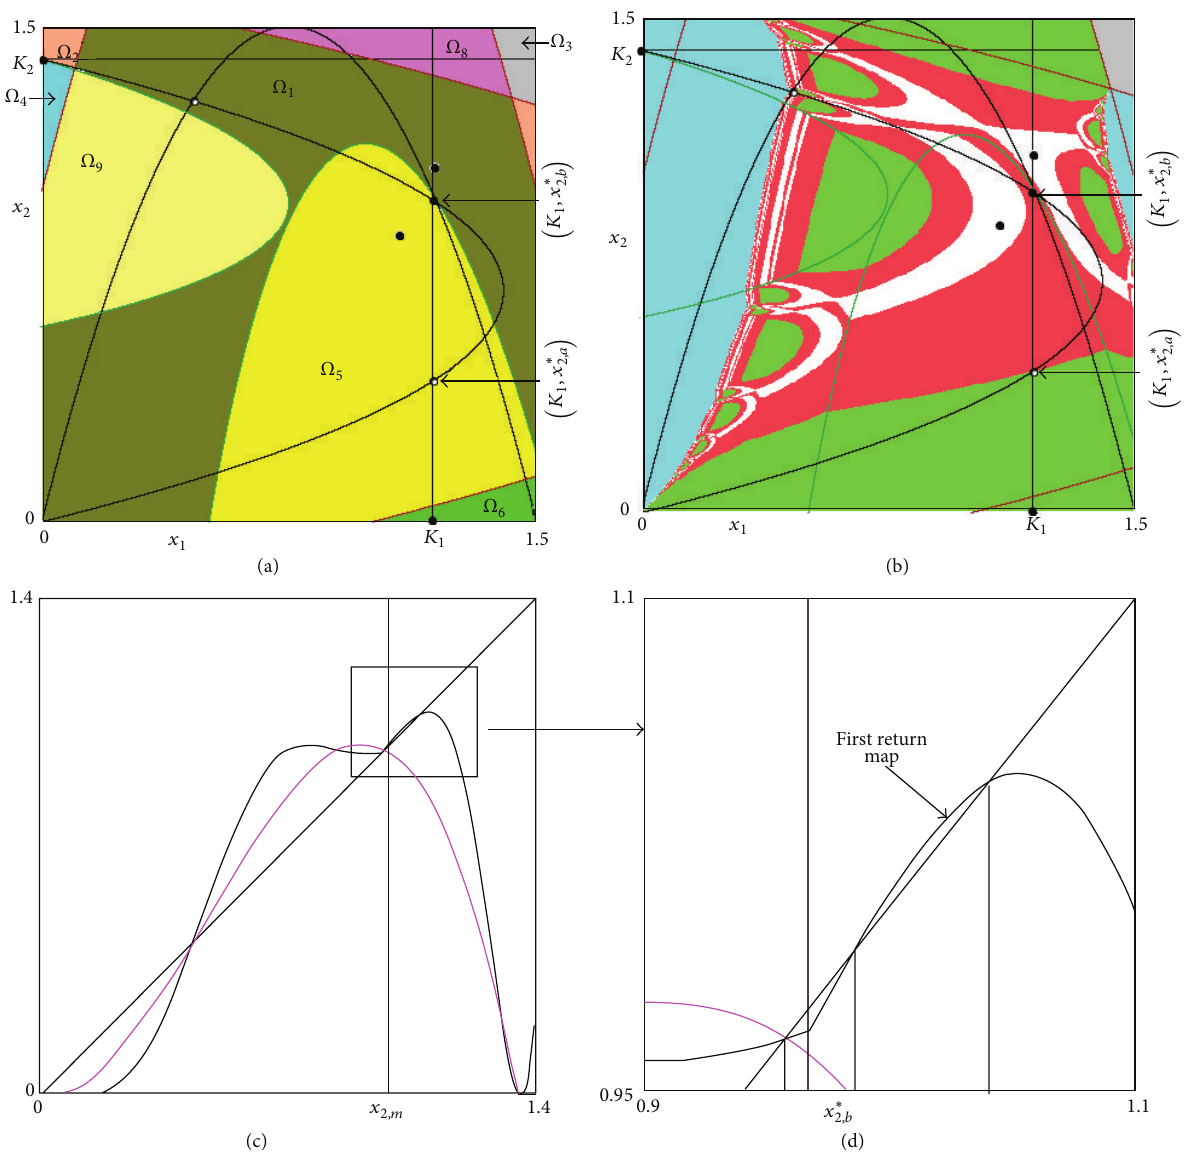
Figure 4: Parameters: 𝑁 1 = 1.5 , 𝑁 2 = 1.4 , 𝜏 1 = 𝜏 2 = 4 , 𝛾 1 = 𝛾 2 = 1 , 𝐾 1 = 1.19 , and 𝐾 2 = 1.4 . Panel (a), phase space divided in regions 𝑖 = 1, ...,9 . Panel (b), the green (resp., azure) region is the basin of attraction of the superstable equilibrium of segregation (𝐾 Ω 𝑖 , ) ), the red region is the basin of attraction of the equilibrium of nonsegregation (𝐾 (0,𝐾 2 of the stable 2-cycle born through a nonsmooth saddle-node bifurcation. In the first two Panels, 𝐵𝐶 1,𝐾 and 𝐵𝐶 2,𝐾 are the dark-green curves and 𝐵𝐶 1,0 and 𝐵𝐶 2,0 the dark-red curves, while 𝜙 1 and 𝜙 2 are the black curves. Panel (c) shows the restriction of the map 𝑇 on 𝑥 1 = 𝐾 1 for ∈ [0, 𝑥 ] in pink and first return map 𝐺(𝑥 ) in black. Panel (d) shows an enlargement of the picture in Panel 𝑥 2 2,𝑚 2